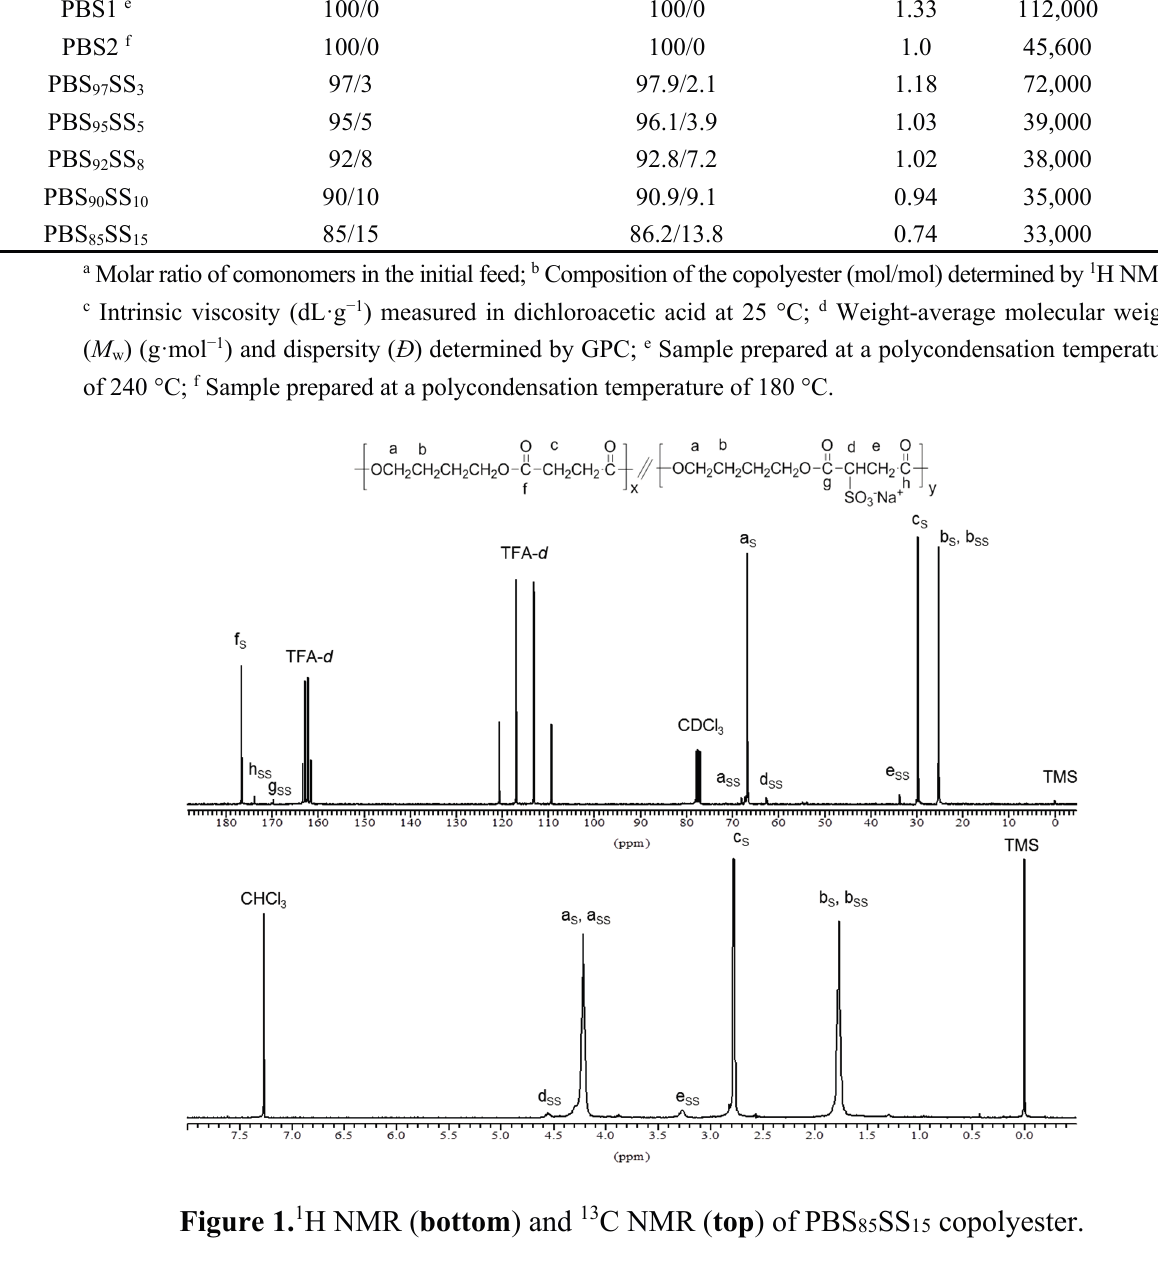
Table 1. Composition and molecular weights of poly(butylene succinate) (PBS) homopolyesters and poly(butylene succinate- co -butylene sulfonated succinate) (PBS x SS y ) copolyesters. Copolyester composition a Copolyester composition b Molecular weights Copolyester S/SS